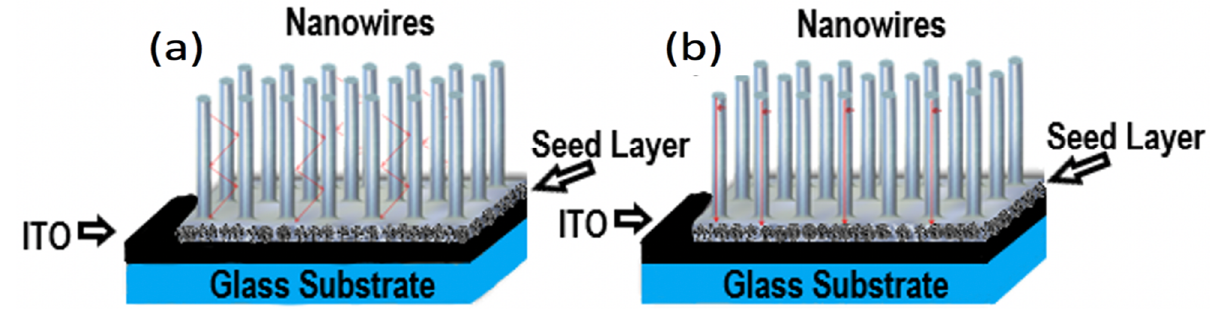
Figure 1. Schematic illustration of nanowires during ( a ) light trapping and ( b ) electron transport to electrodes.